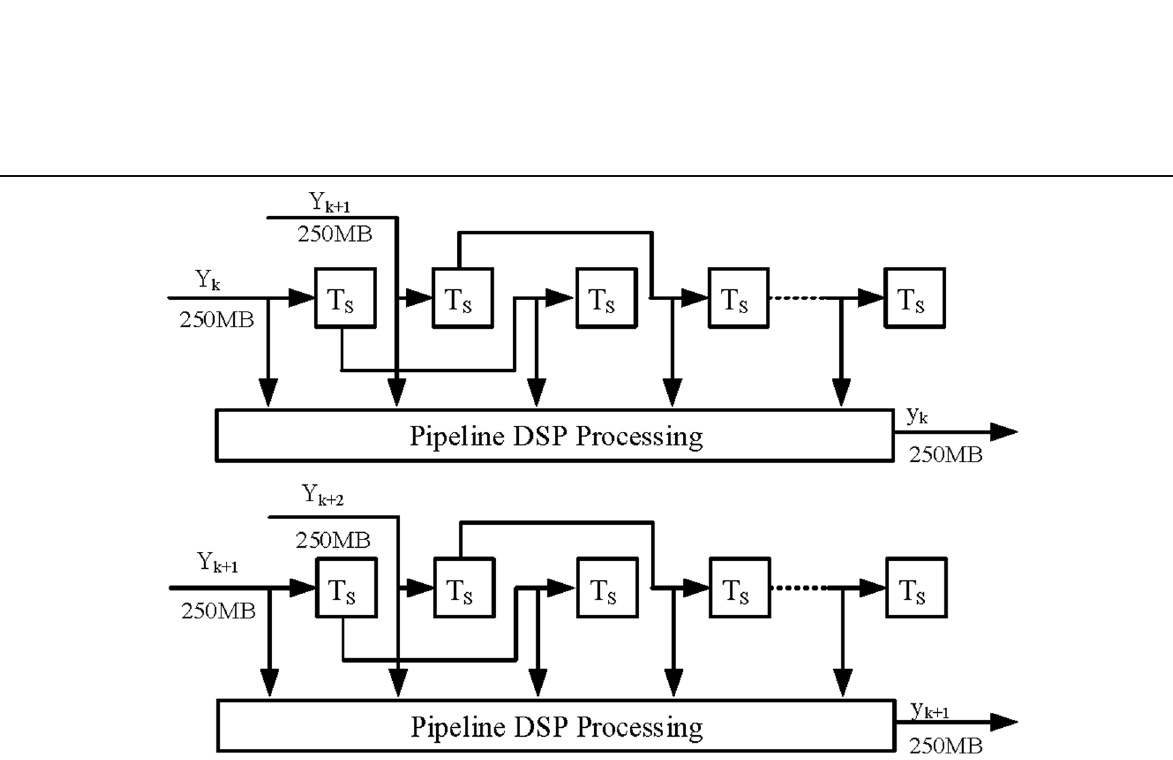
Fig. 8 Improved parallel structure. This figure shows an improved parallel